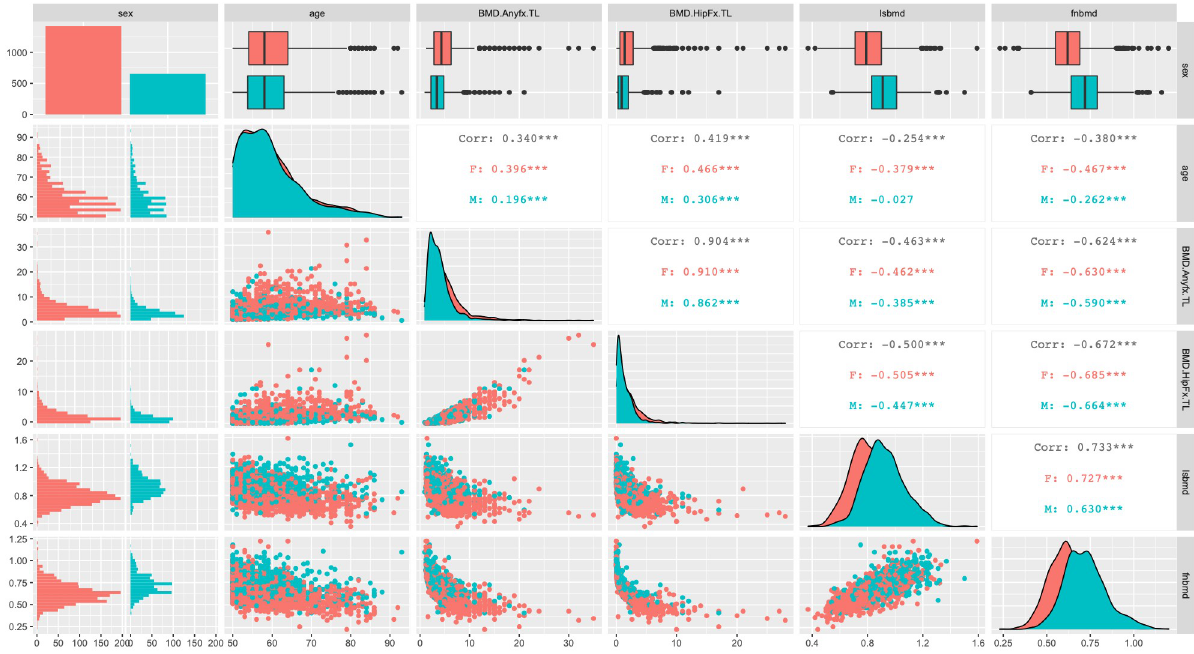
with the correlation coefficient ranging from 0.40 to 0.70; however, this should be interpreted with care, because the relationship was not linear. The distribution of 10-year risks of fracture stratified by age and 10-year age group are shown in Table 2 . Generally, the 10-year risk was higher in women than men, and in each gen- der, the risks were increased with advancing age. Approximately 1% (n = 11) of women and 0.1% (n = 1) of men had 10-year risk of major fracture � 20%. However, 23% (n = 327) of